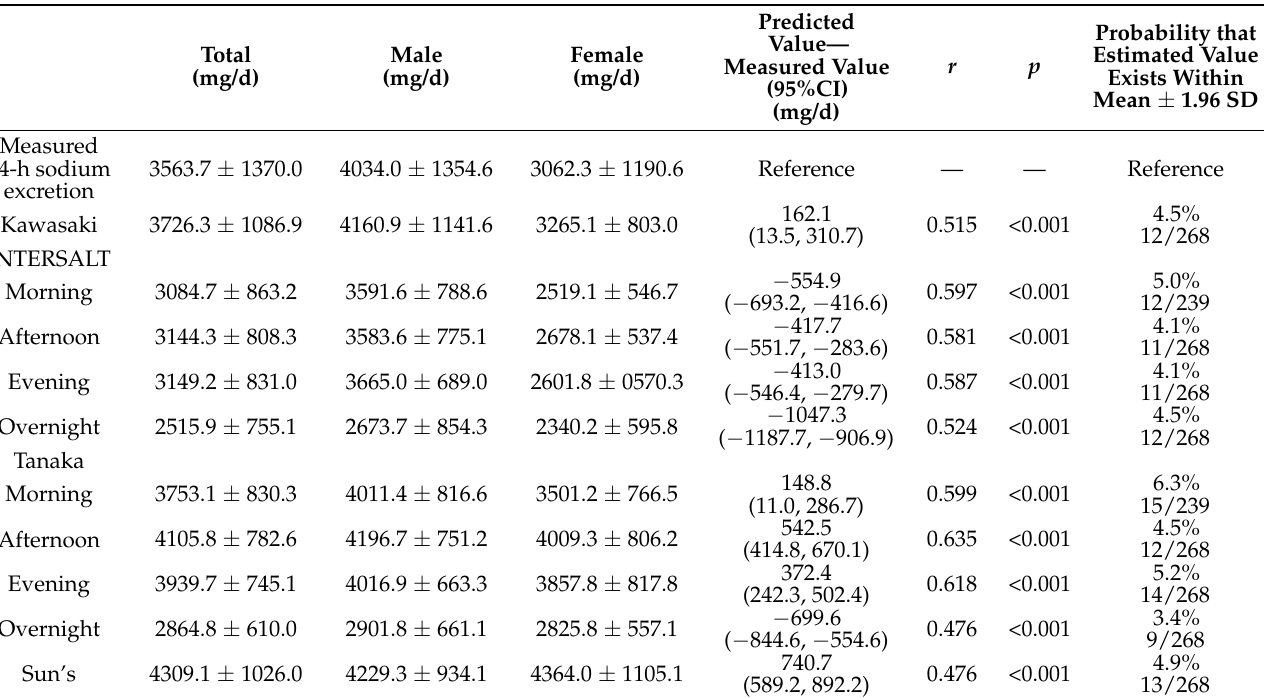
Table 4. Comparison of the average level of daily sodium intake estimated by the four methods with the actual measured values in